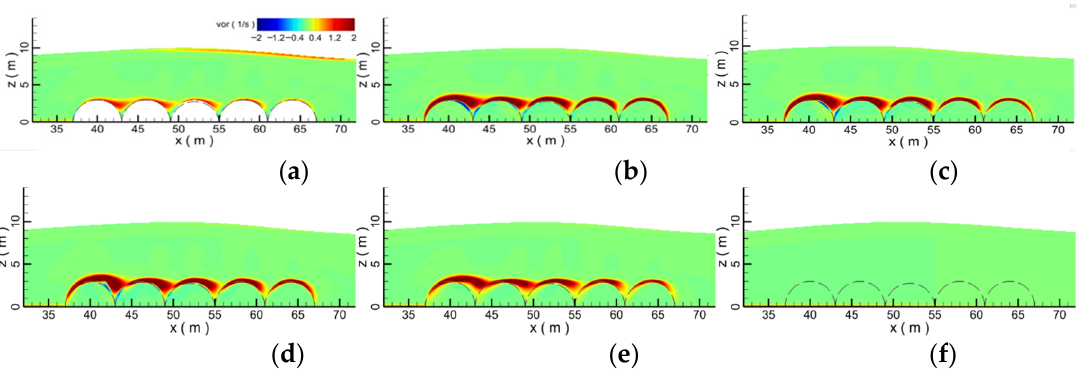
Figure 8. The vorticity contour of the wave peak on the breakwaters under different porosities; ( a ) por = 0.0; ( b ) por = 0.2; ( c ) por = 0.4; ( d ) por = 0.6; ( e ) por = 0.8; ( f ) por = 1.0.